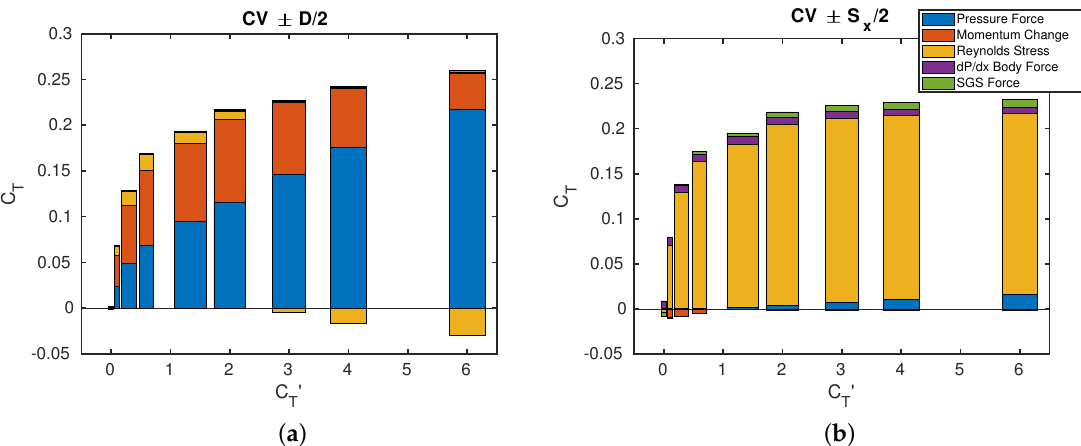
Figure 11. Detailed breakdown of C T budget by term in the momentum budget equation, plotted as a function of as a function of C (cid:48) , and comparing two different streamtube control volumes. ( a ) budget T breakdown for the small control volume, with streamwise extent of 1 turbine diameter. ( b ) budget breakdown for the large control volume, with streamwise extent of one row separation.